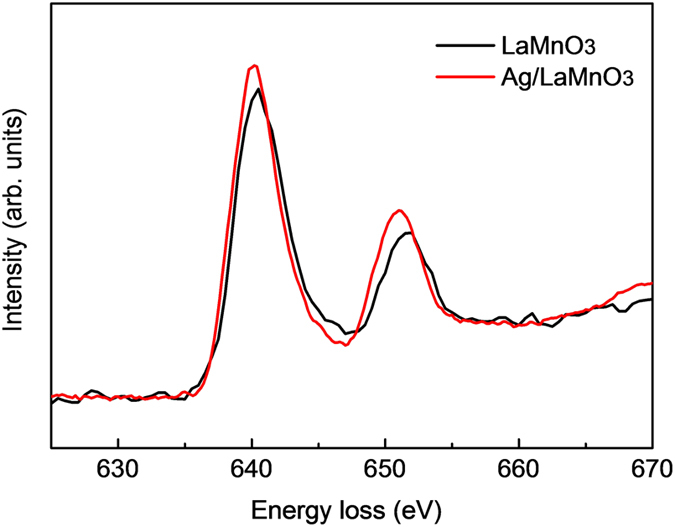
Mn L2,3 edge EELS obtained from Ag/LaMnO3 and LaMnO3.